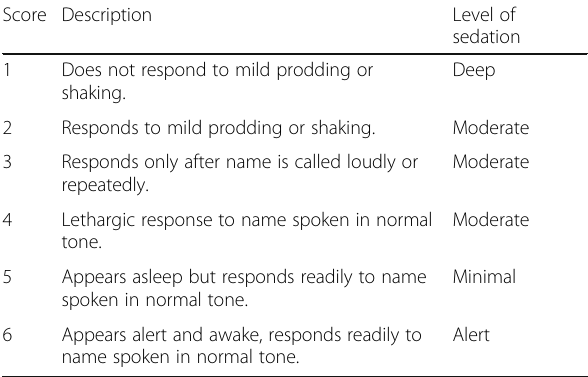
Table 1 Modified Observer ’ s Assessment of Alertness/Sedation Scale (Cohen et al., 2007) Score Description